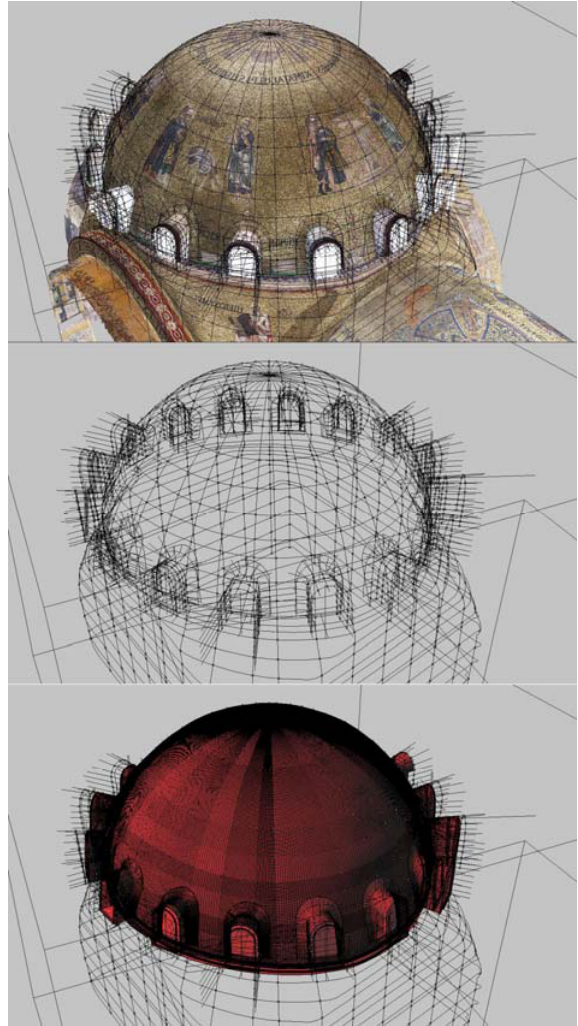
Figure 6: for the most complex vaults and domes, a network of sections was extracted from the point cloud and is used to build the geometric model